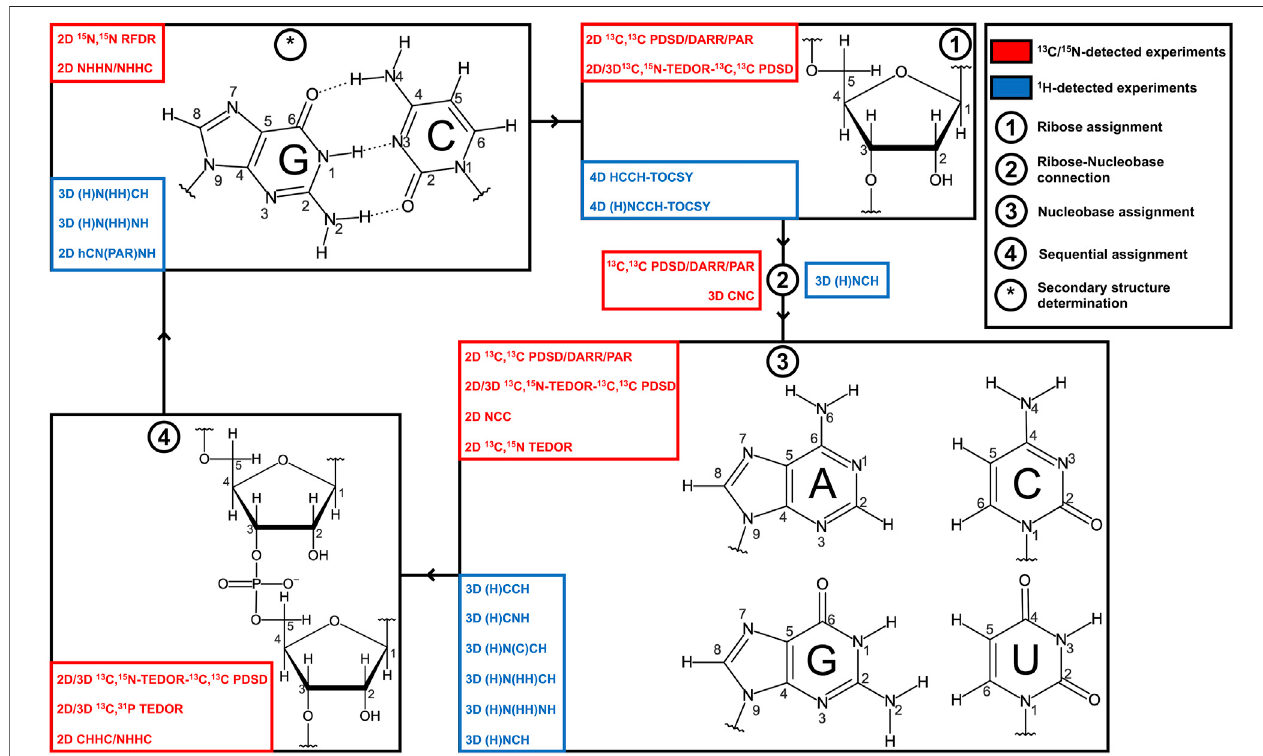
FIGURE 1 | Strategies for RNA resonance assignment by ssNMR. Nucleobase and ribose structures are shown. 13 C/ 15 N-detected and 1 H-detected experiments utilized for the different steps of the assignment protocol are shown in blue and red boxes, respectively.